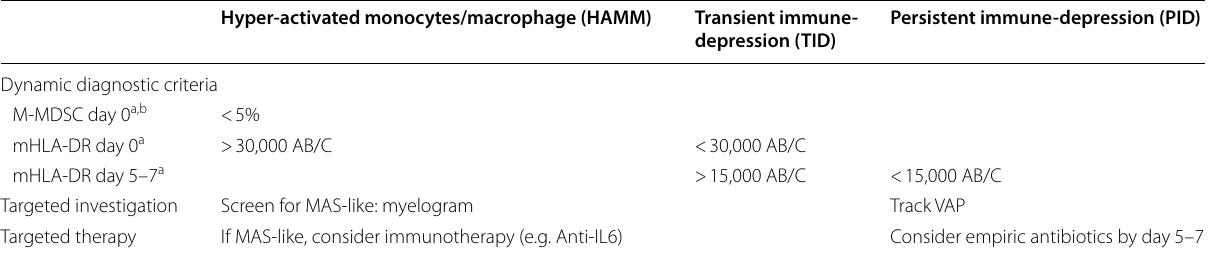
M-MDSC, monocytes myeloid-derived suppressor cell to total monocytes ratio defined as CD19 − CD14 + CD15 − CD11b + HLA-DR − cells/CD19 − CD14 + CD15 − cells; mHLA-DR, monocytes Human leukocyte antigen-DR; AB/C, antibody per cell; MAS, macrophage activation syndrome; VAP, ventilator-associated